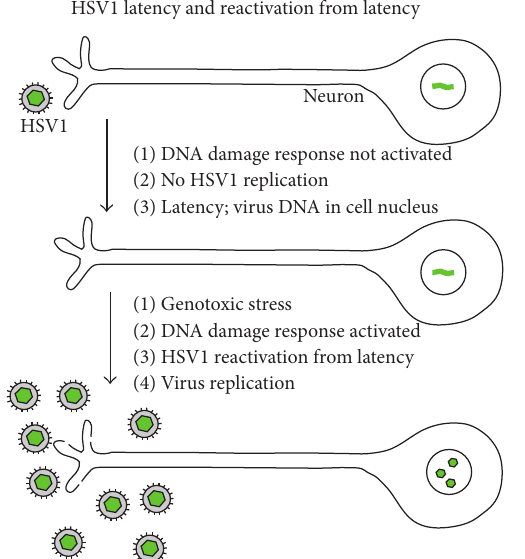
Figure 2: Illustration of HSV1 entry into latency and reactivation as proposed in the DNA repair-centered pathway. Note that DNA damage response proteins are not activated following entry of HSV1 into neurons, a condition that permits virus entry into latency. Note also that reactivation occurs following an accumulation of DNA damage in the latently infected cell. Reactivation results in HSV1 replication in the neuron as illustrated